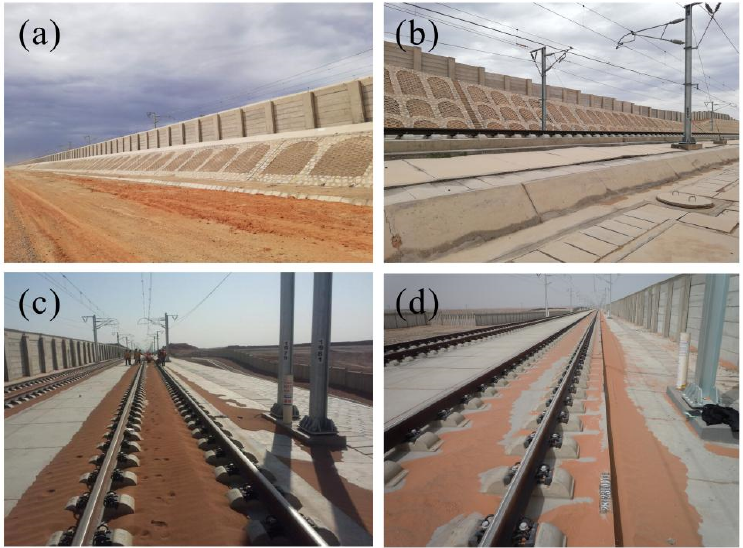
Figure 1. ( a ) Convex subgrade and ( b – d ) concave subgrades. Note: The wind-break wall is different from the sand fence (see Appendix